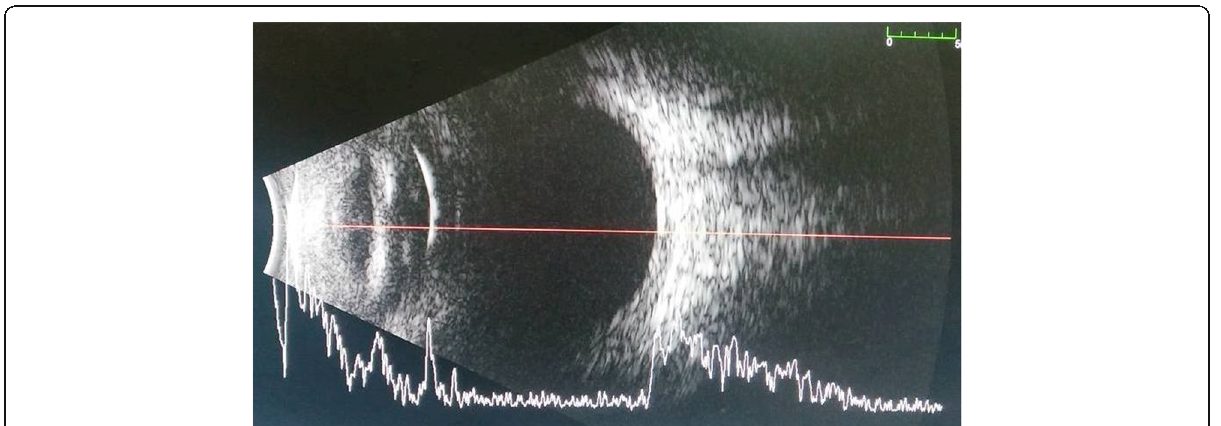
Fig. 1 Day 2 post-laser B-scan ultrasound, axial horizontal, documents low amplitude vitreous echoes with good aftermovement and a prominent